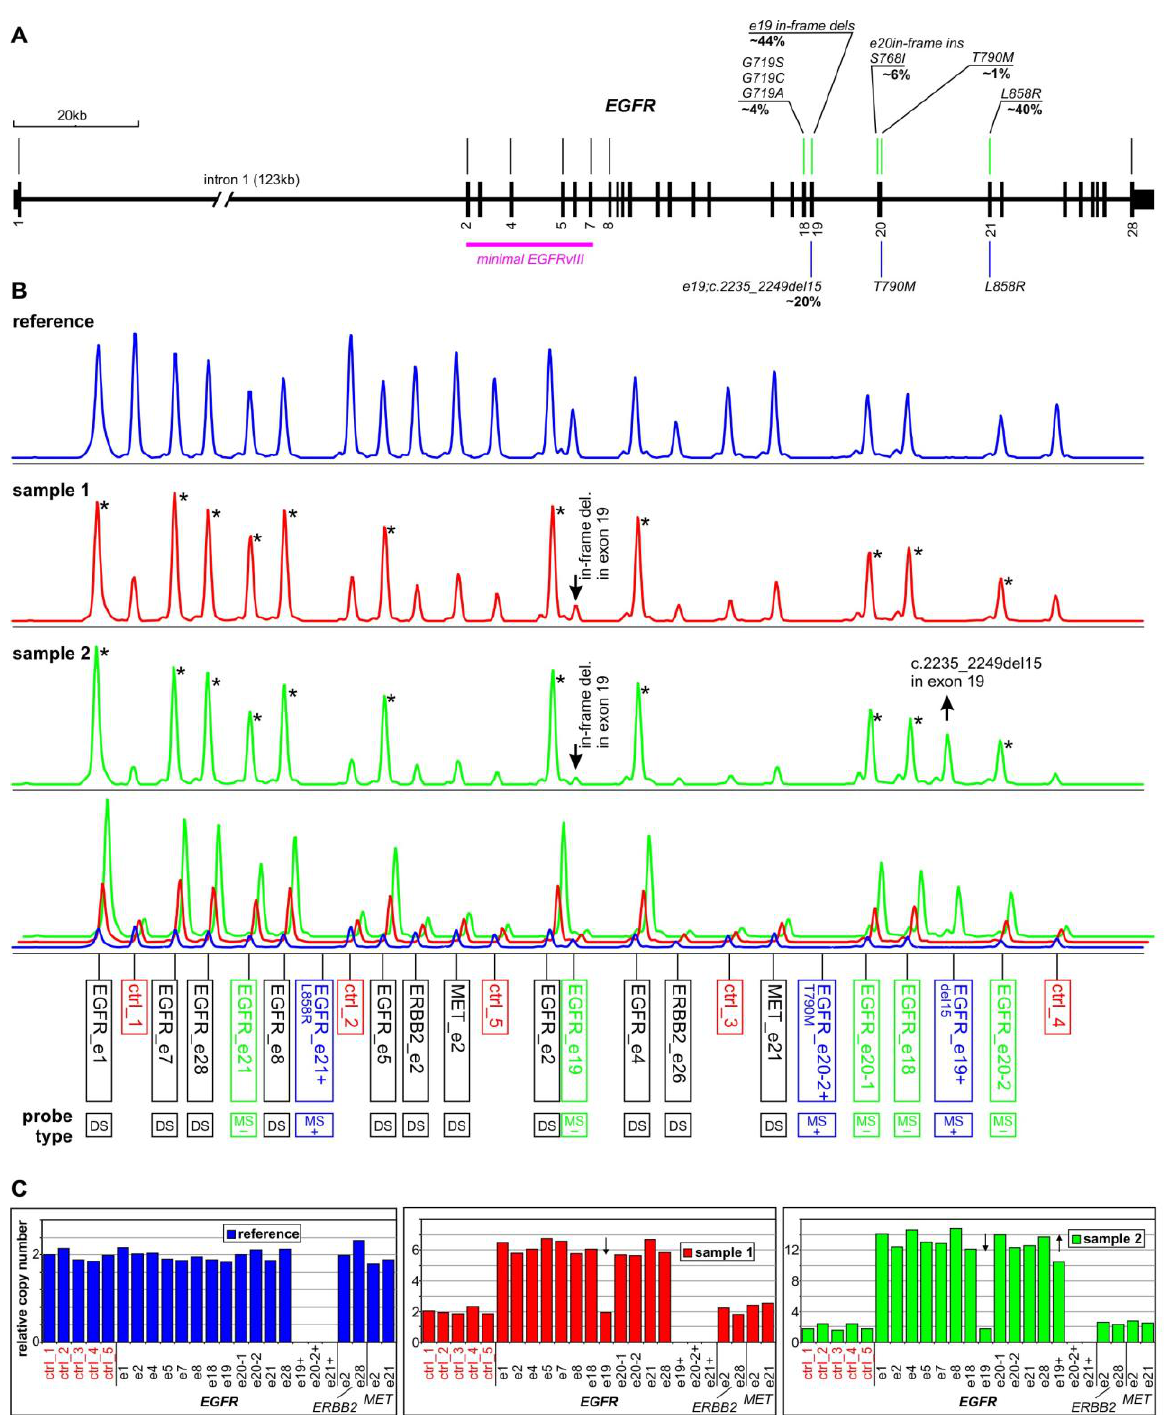
FIGURE 5. Representative results from the EGFRmut+ MLPA assay for combined copy number and small-mutation analysis of the EGFR gene. (A) Map of the EGFR gene with the positions of the EGFRmut+ probes indicated (vertical lines over and under the map). Black, green, and blue lines indicate the DS, MS-, and MS+ probes, respectively. The oncogenic small mutations (and their frequencies) covered by the MS- and MS+ probes are indicated over and under the corresponding probes, respectively. (B) Electropherograms represent (from the top) the reference sample, cancer sample 1, cancer sample 2, and an overlay of all three samples. Probe IDs and types are indicated under the electropherograms. Asterisks indicate amplified signals; arrowheads indicate reduced signal from MS- probe EGFR_e19 (specific for all in- frame deletions in exon 19) and increased signal of MS+ probe EGFR_e19+ (specific for deletion c.2235_2249del15). (C) Bar plots (corresponding to the electropherograms shown above [B]) represent the normalized copy number value (y-axis) of each probe